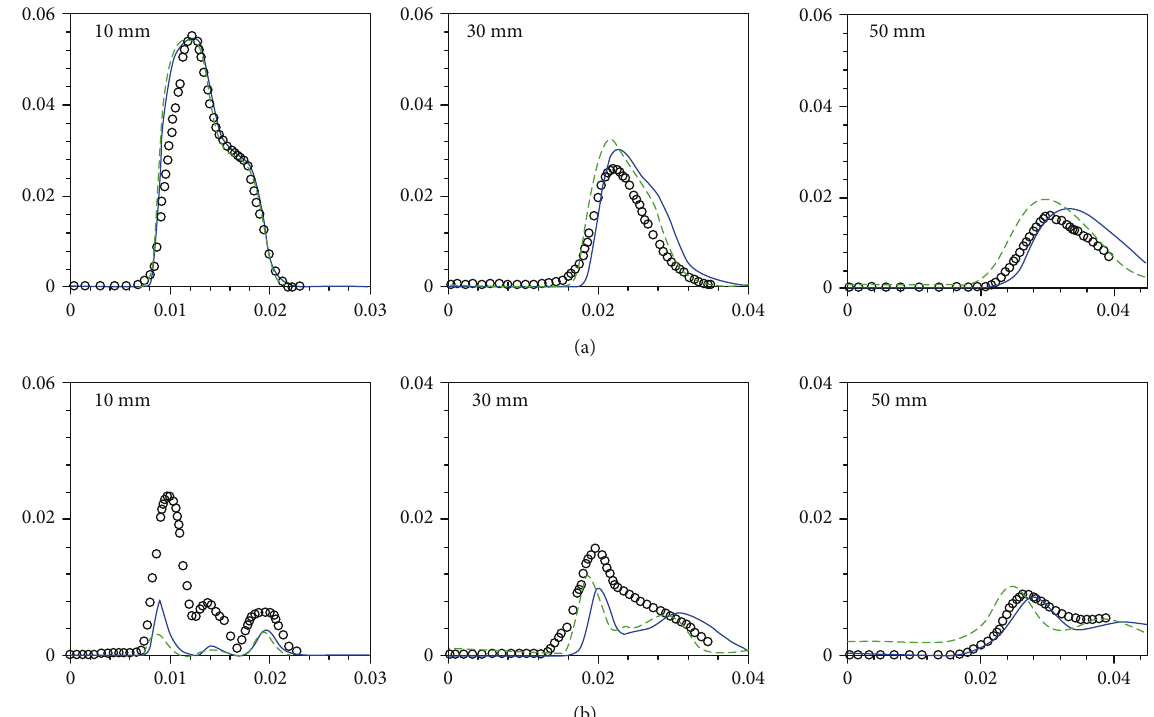
Figure 10: Comparison of mean (a) and rms (b) CH line, Mech I simulation; solid line, Mech II simulation).